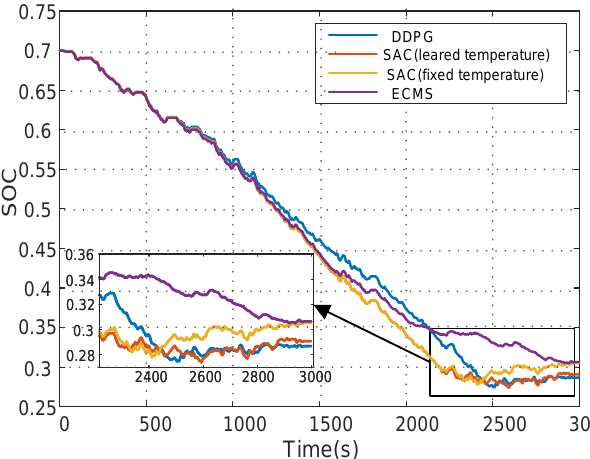
Figure 16. The SOC trajectories of four strategies. Table 4. The comparison of fuel consumption in three